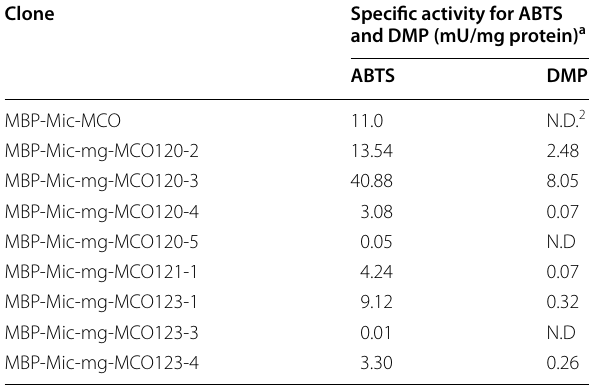
a Activity in the crude extract of recombinant E. coli N.D. not detected